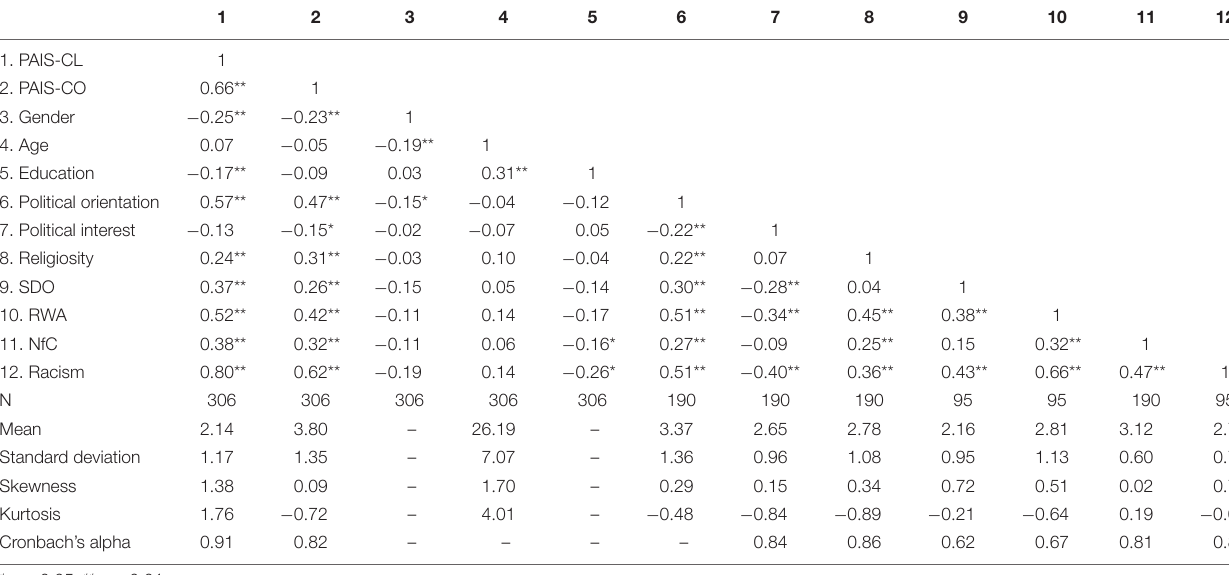
TABLE 3 | Correlations, means, standard deviations, kurtosis, skewness, and Cronbach’s alpha values.